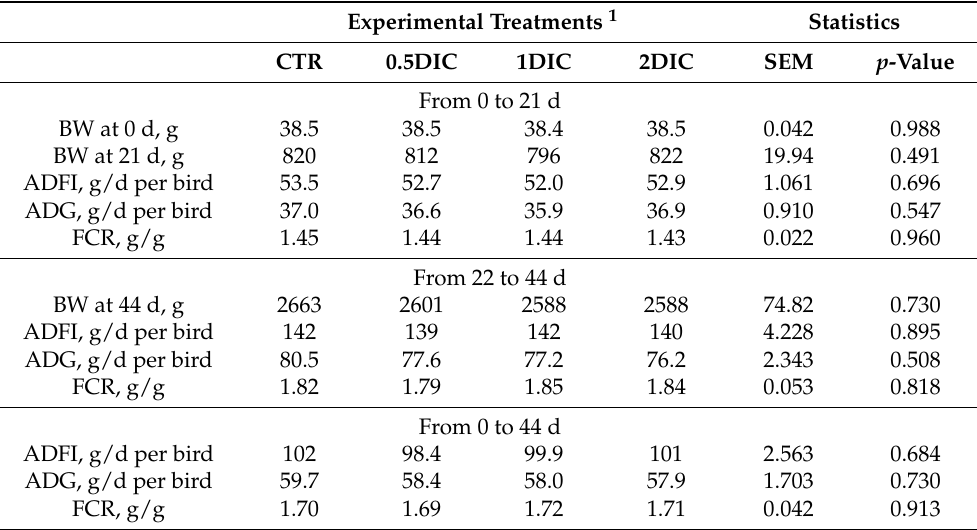
Table 3. Effects of dietary DIC supplementation level on growth performance of broiler chickens (Experiment 1). Experimental Treatments 1 Statistics